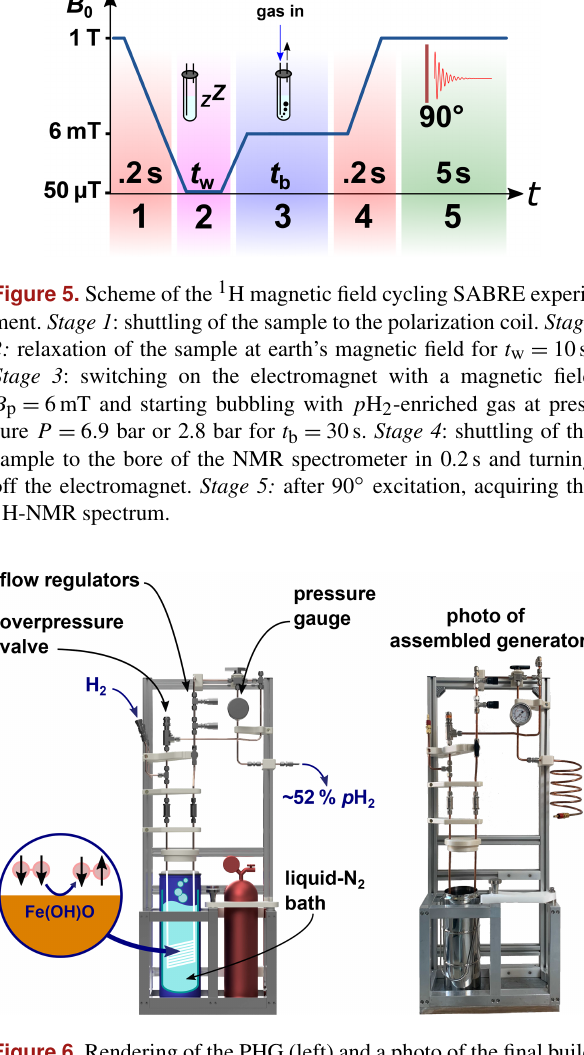
Figure 6. Rendering of the PHG (left) and a photo of the final build (right). The design of the PHG is open-source and simple and uses off-the-shelf as well as 3D-printed